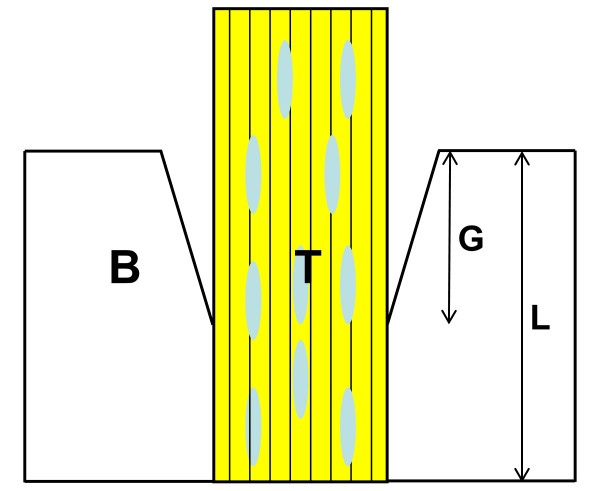
Schematic view of a gap area between a tendon graft and bone. T = tendon graft, B = bone, G = length of a gap area from a joint aperture site, L = length of a tendon graft in a bone tunnel. Gap area percentage (%) = (G - L) × 100/L.